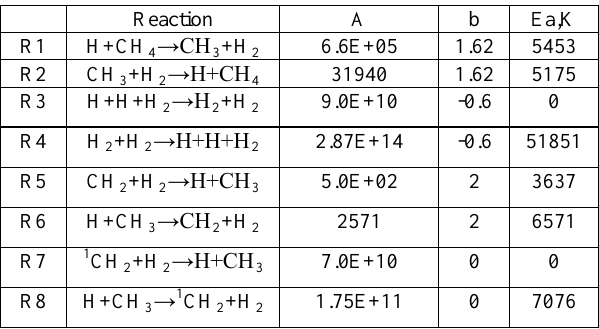
Table 2. List of volumetric reactions and corresponding rate constant parameters [1, 10] (Arrhenius form, AT b exp(-Ea/T), A is in m 3 /kmol ⋅ s).